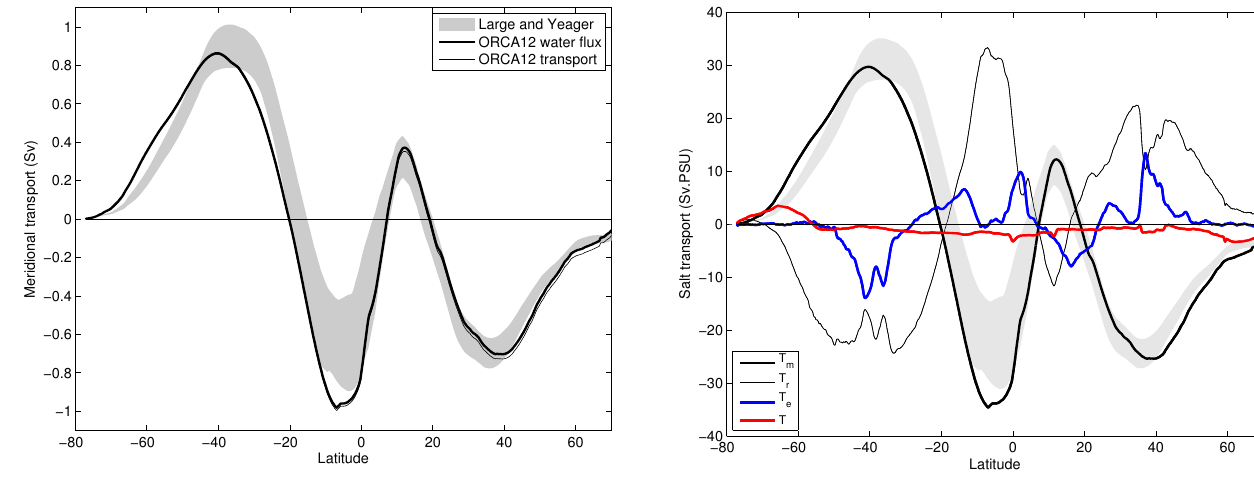
Fig. 4. Decomposition of the global meridional transport of salt in the ORCA12 simulation. See text (Eq. 8) for the explanation of the different terms. The grey shading is the observed salt flux carried by the net volume flux at each latitude: it is computed from the data of Large and Yeager (2009) (similar to Fig. 3) combined with the Levitus depth-averaged salinity